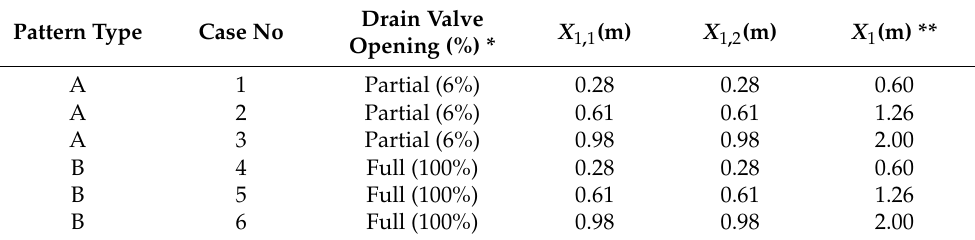
Table 2. Types of behaviours stipulated for the study cases.